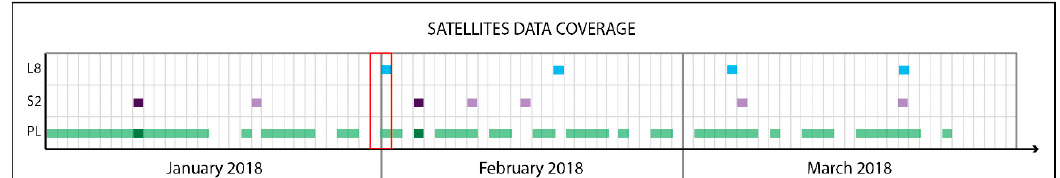
Figure 5. Schematic three-month timeline for satellite data coverage of Landsat 8 (L8), Sentinel 2 (S2) and Planet Labs (PL). Only usable data, with no cloud coverage over the study area are considered. Images selected for NDVI analysis are marked with darker colours. The red box shows the February 2018 event period.